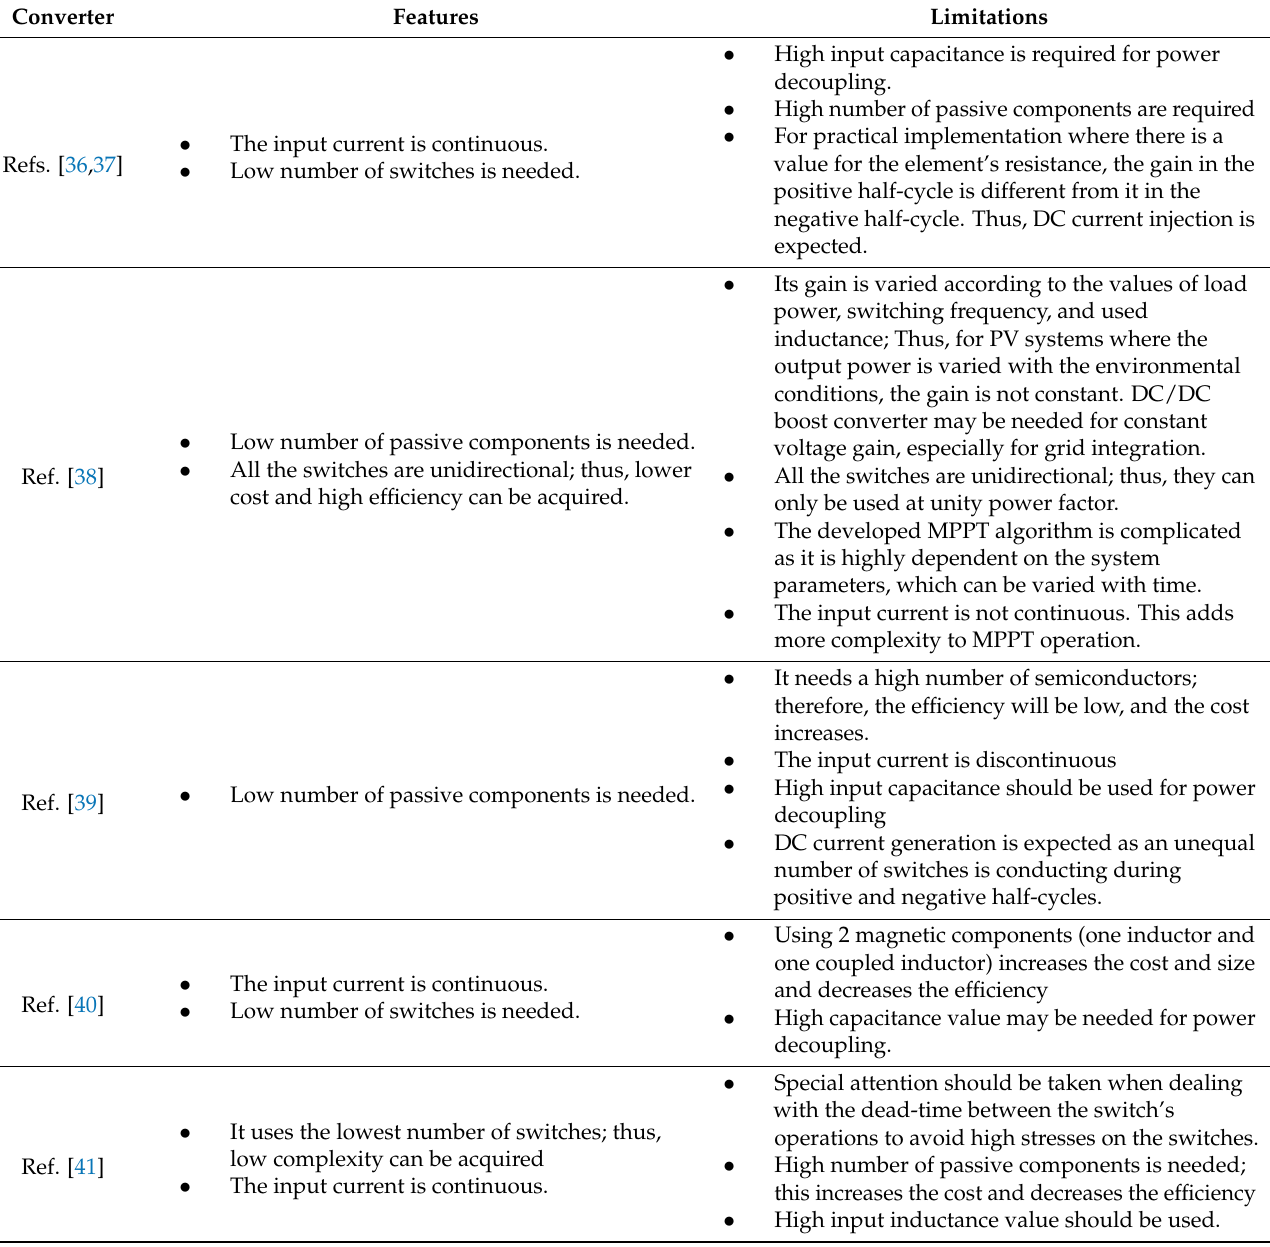
Table 4. Features and limitations of current-source CG